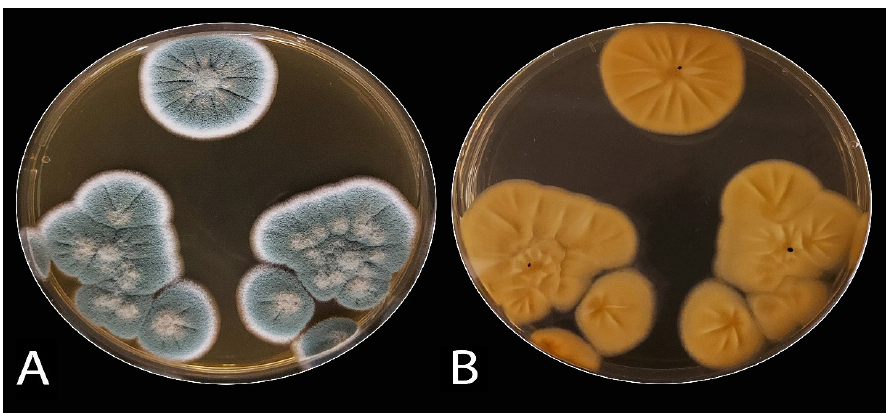
Figure 2. Colony morphology of P. polonicum on malt extract agar (MEA) medium: ( A ) obverse and ( B ), reverse.